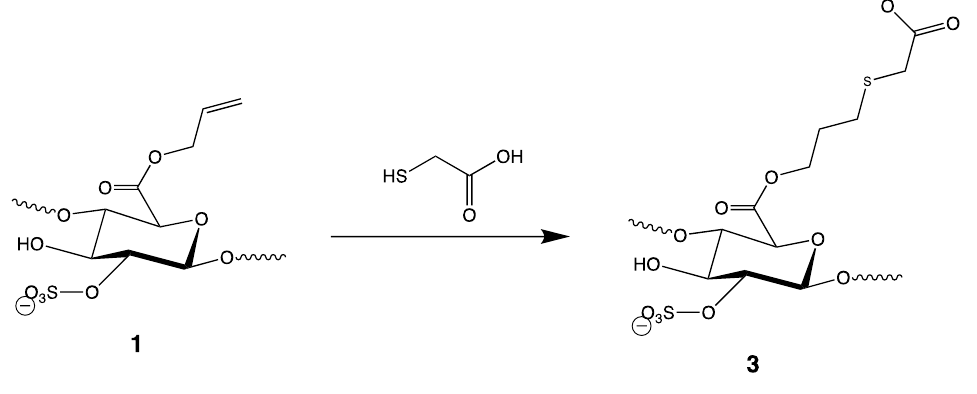
Figure 4. Thiol-ene reaction of [1] with mercaptoacetic acid.